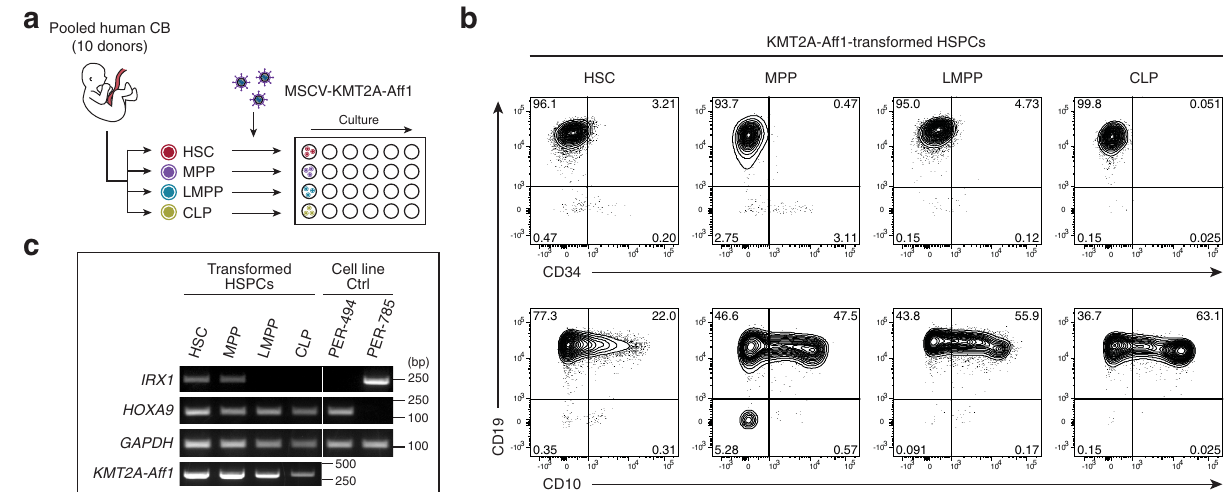
Fig. 7 | IRX-type leukemia-initiating potential is lost earlier in B-cell develop- ment than HOXA-type potential. a Schematic outline of in vitro CB transforma- tion assay. CB HSPCs were sorted, transduced with KMT2A-Aff1, and cultured on MS-5 stroma cells under lymphoid conditions. b Flow cytometry plots of KMT2A-